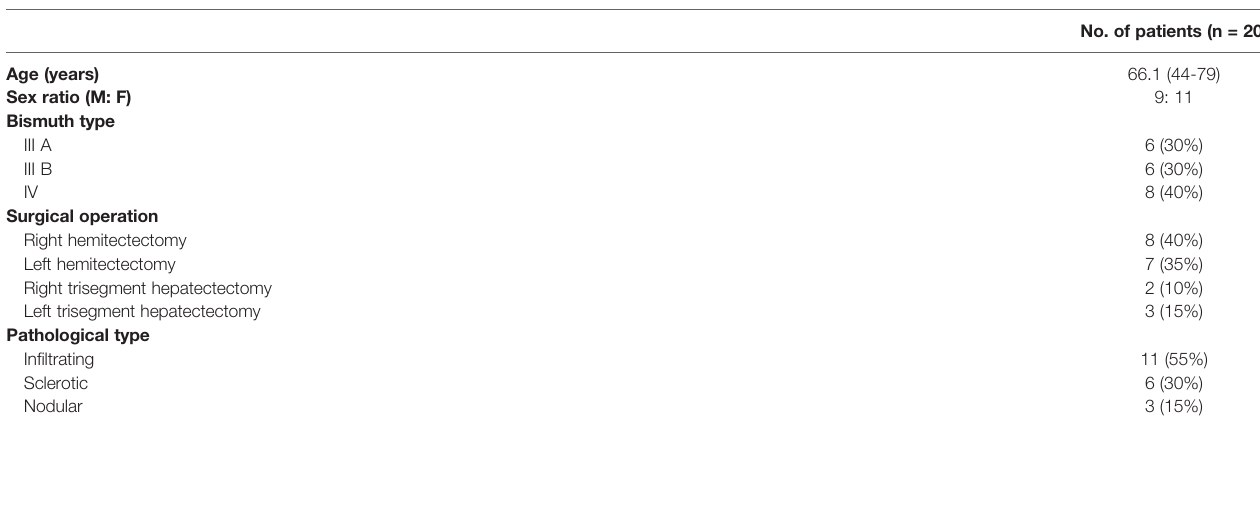
TABLE 1 | Demographic and preoperative